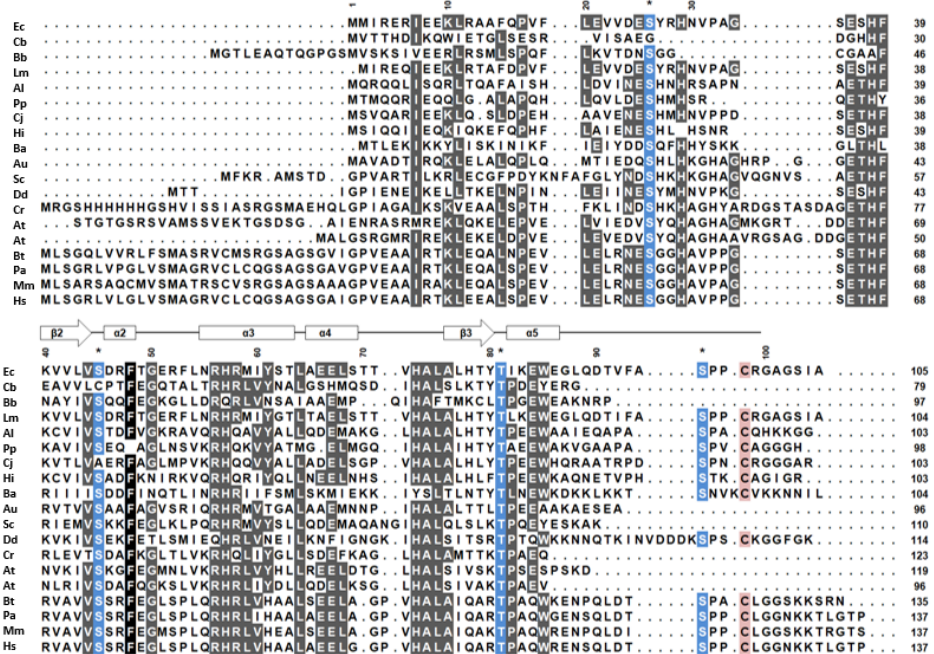
Figure 2. Phylogenetic analysis of BolA-like proteins. ClustalW multiple sequence alignment of E. coli BolA protein, used as template, with BolA-like proteins from prokaryotes and some eukaryotic organisms. Identical residues are in gray and black. The putative E. coli phosphorylated residues, are highly conserved and colored in blue. The only cysteine present in E. coli BolA is also highly conserved and is colored in rose. The * represents the phosphorylated sites in E. coli . The secondary αββαβ structure was predicted in Net Secondary Structure Prediction Jalview . The secondary structure, regarding E. coli BolA protein, is shown above the alignment. The sequence ID for the proteins is presented: Ec: E. coli -WP_024139872.1; Cb: Coxiella burnetii - AAO90126.1; Bv: Babesia